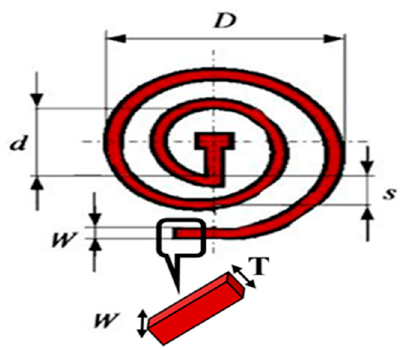
Figure 6. Geometry of a circular spiral coil.